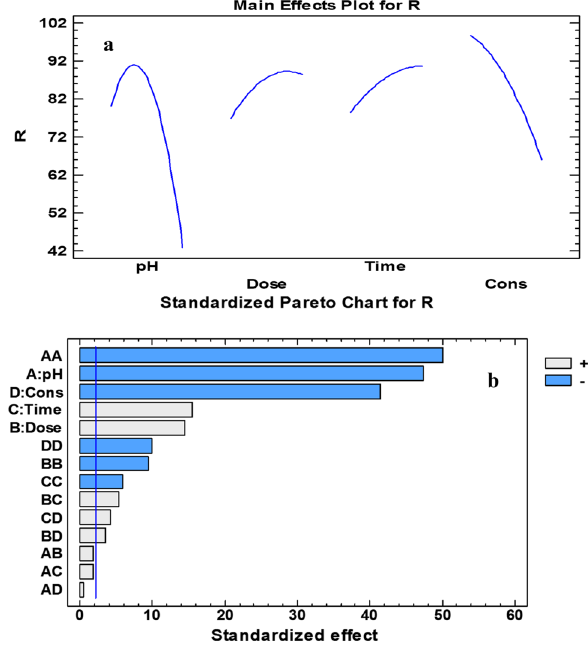
Fig. 4 Initial effect of considered parameters ( a ), effect of all factors on DZN removal ( b